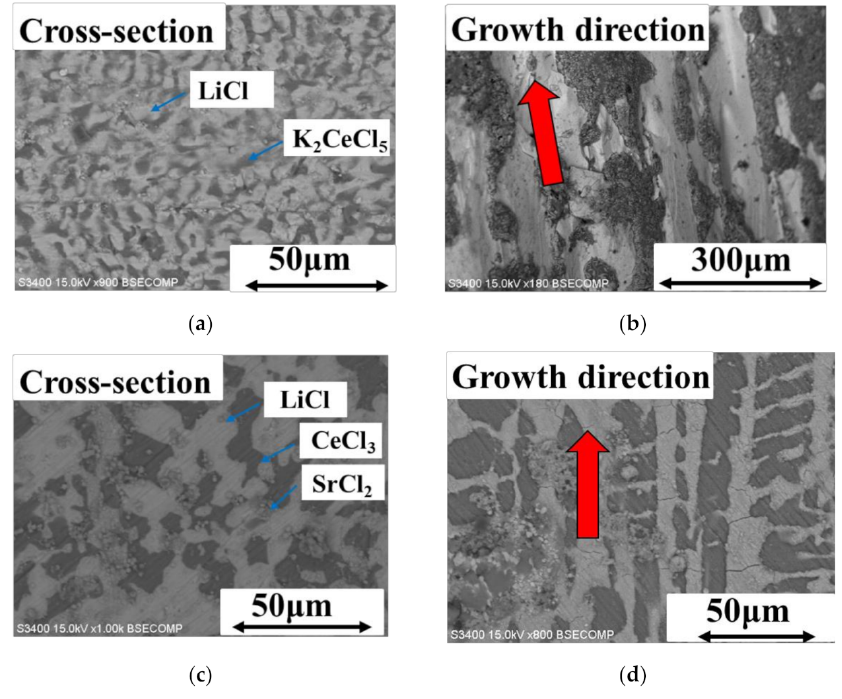
Figure 3. BSE images of ( a ) K 2 CeCl 5 /LiCl cross-section and ( b ) growth direction and ( c ) CeCl 3 /SrCl 2 /LiCl cross-section and ( d ) growth direction.